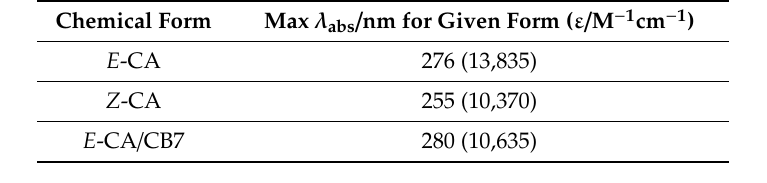
Figure 4. UV − visible absorption spectra of E - and Z -CA (20 μ M) in water at pH 6 and 298 K upon irradiation from a UV (300 nm) lamp for three minutes without ( a ) and with 1 mM CB7 ( b ). For clarity, the initial and final spectra are shown in matching colors with the dominant chemical species (the structures are given in Chart 1). The numbers are the corresponding maxima (in nanometers) and irradiation time (in minutes). Table 2. Absorption features of E and Z isomers of CA in water at pH 6 and 298 K. Chemical Form